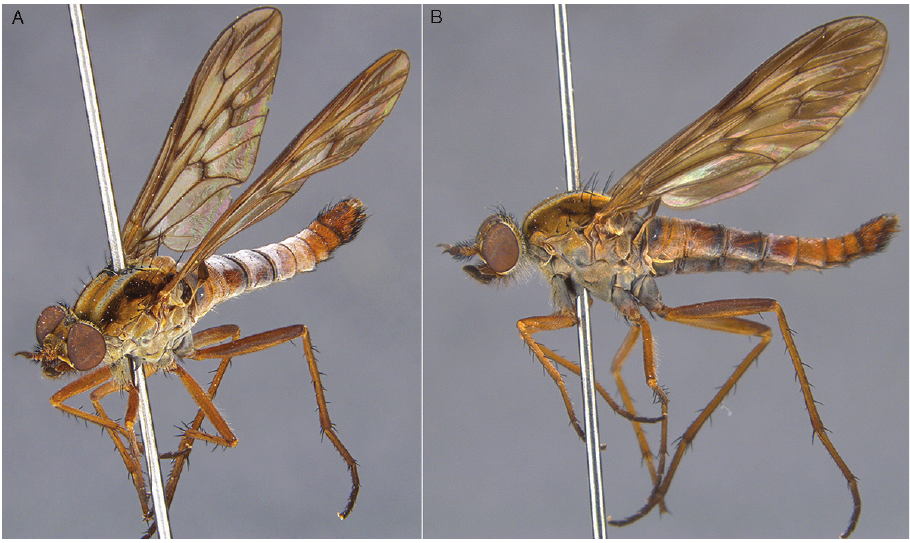
Figure 14. Sidarena macfarlandi sp. n.: A Male oblique view B same, lateral view.